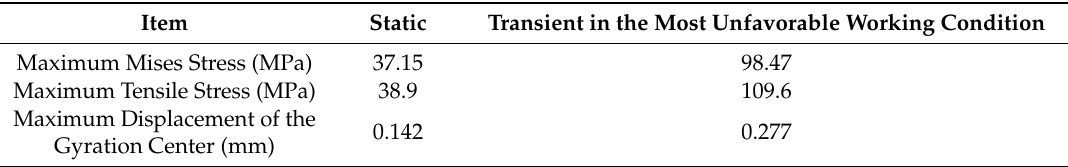
Figure 11. Maximum tensile stress distribution in the most unfavorable working condition.